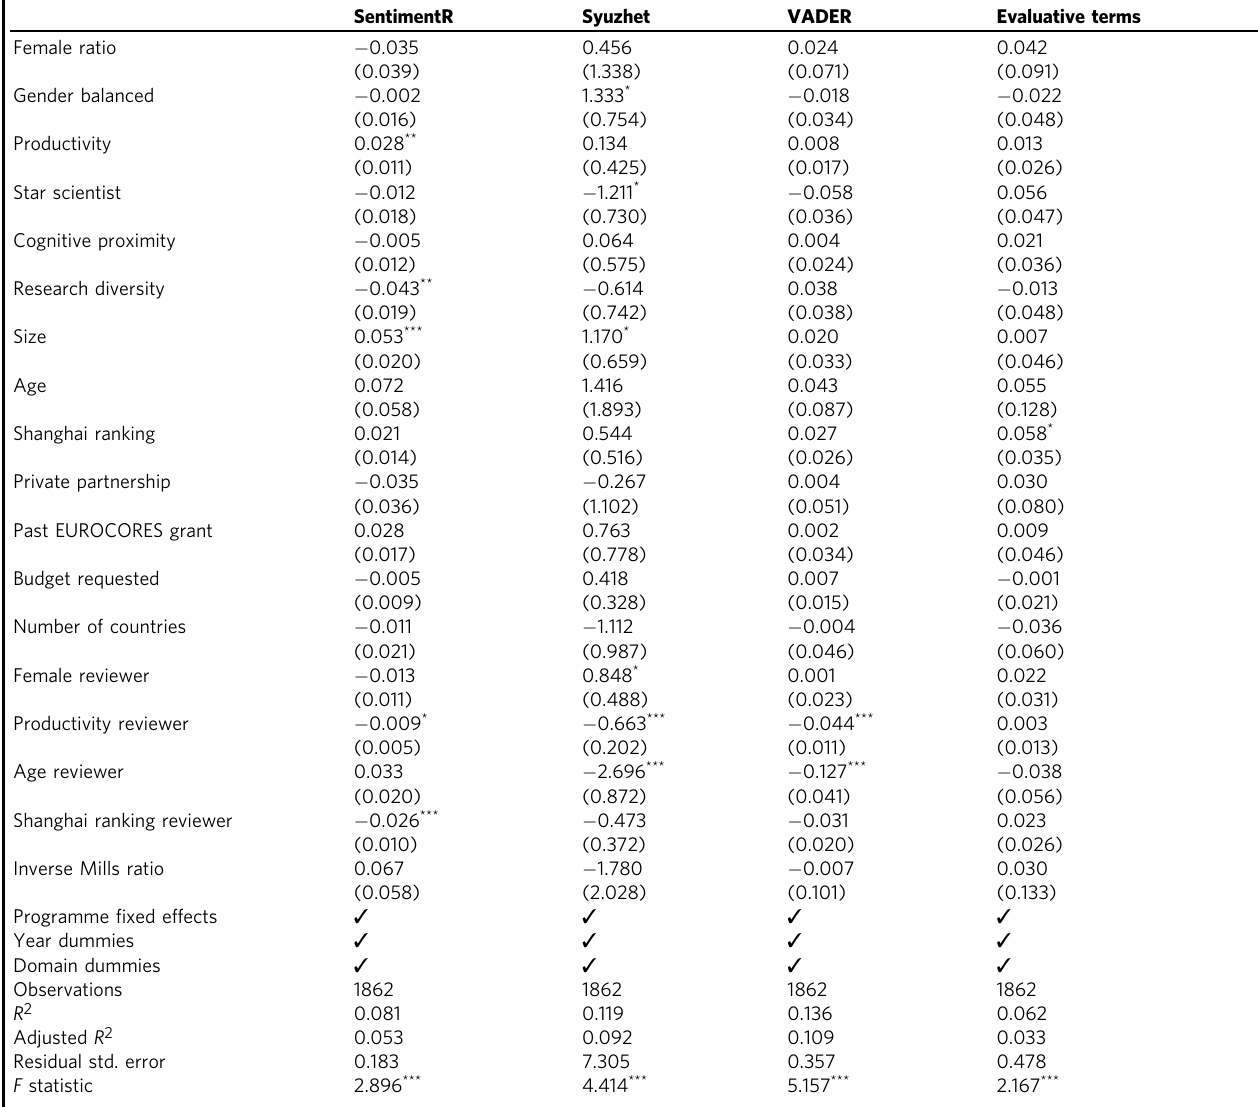
Table 4 Coef fi cient estimates — external reviewer evaluation (sentiments and evaluative